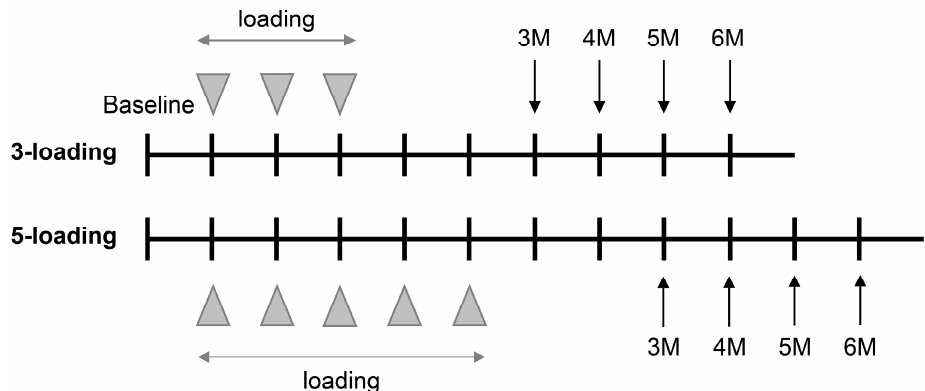
Figure 1. Scheme of treatment and follow-up protocol by intravitreal aflibercept loading regimen in eyes with diabetic macular edema. Follow-up period is presented as months (M) after the last loading injection.